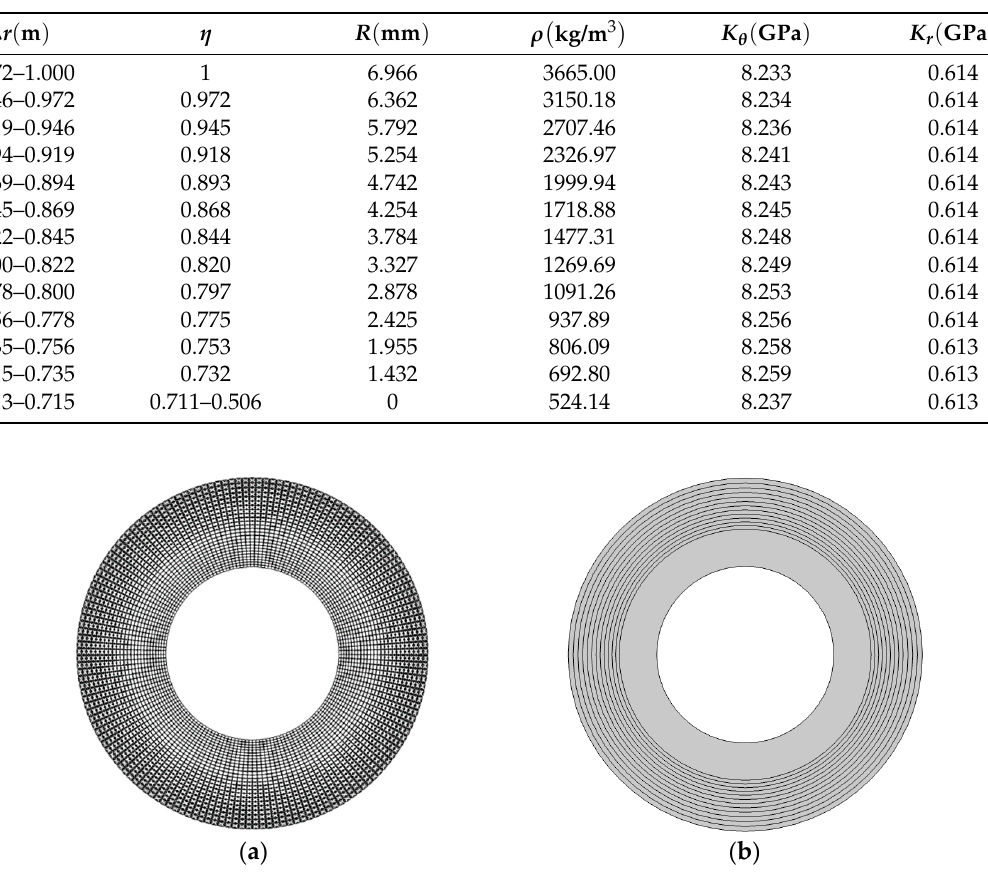
Table 1. Parameter distribution of pentamode materials in each layer.